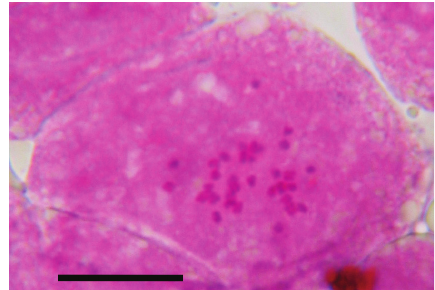
Figure 5. Gypsophila arrostii Guss. subsp. arrostii , 2 n = 34. Scale bar: 10